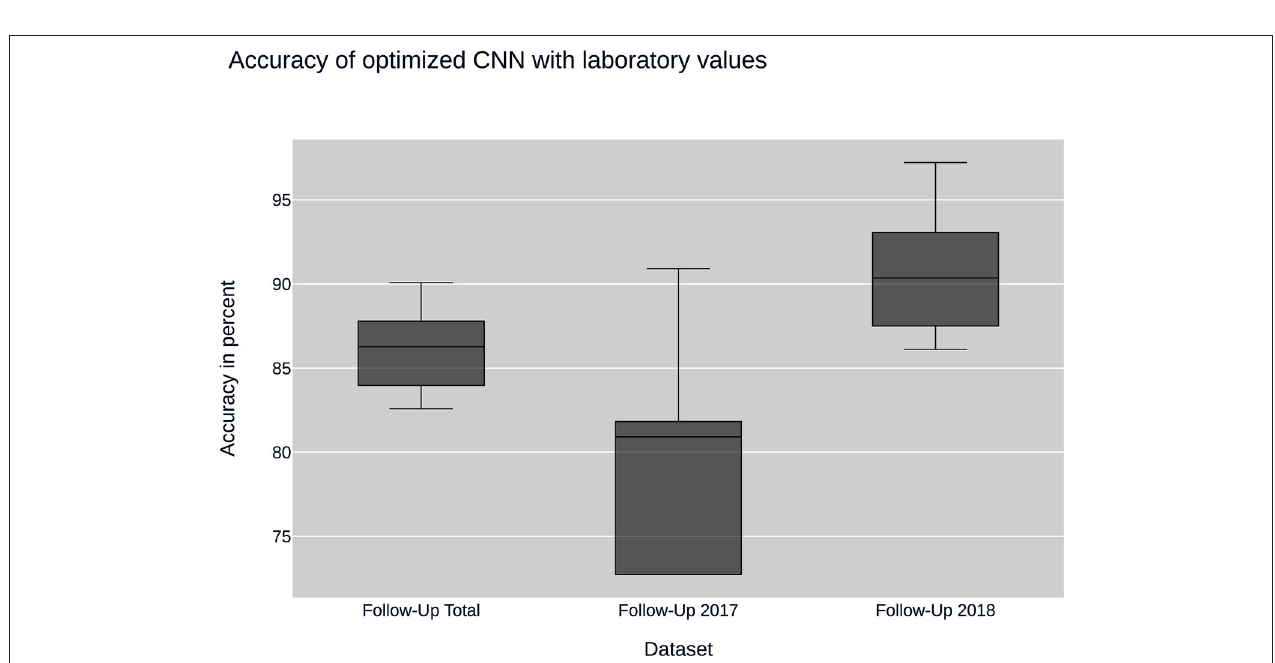
FIGURE 4 | CNN performance with laboratory values: illustrates the performance of the convolutional neural network (CNN) on datasets containing laboratory values. The datasets are sampled by year of collection.